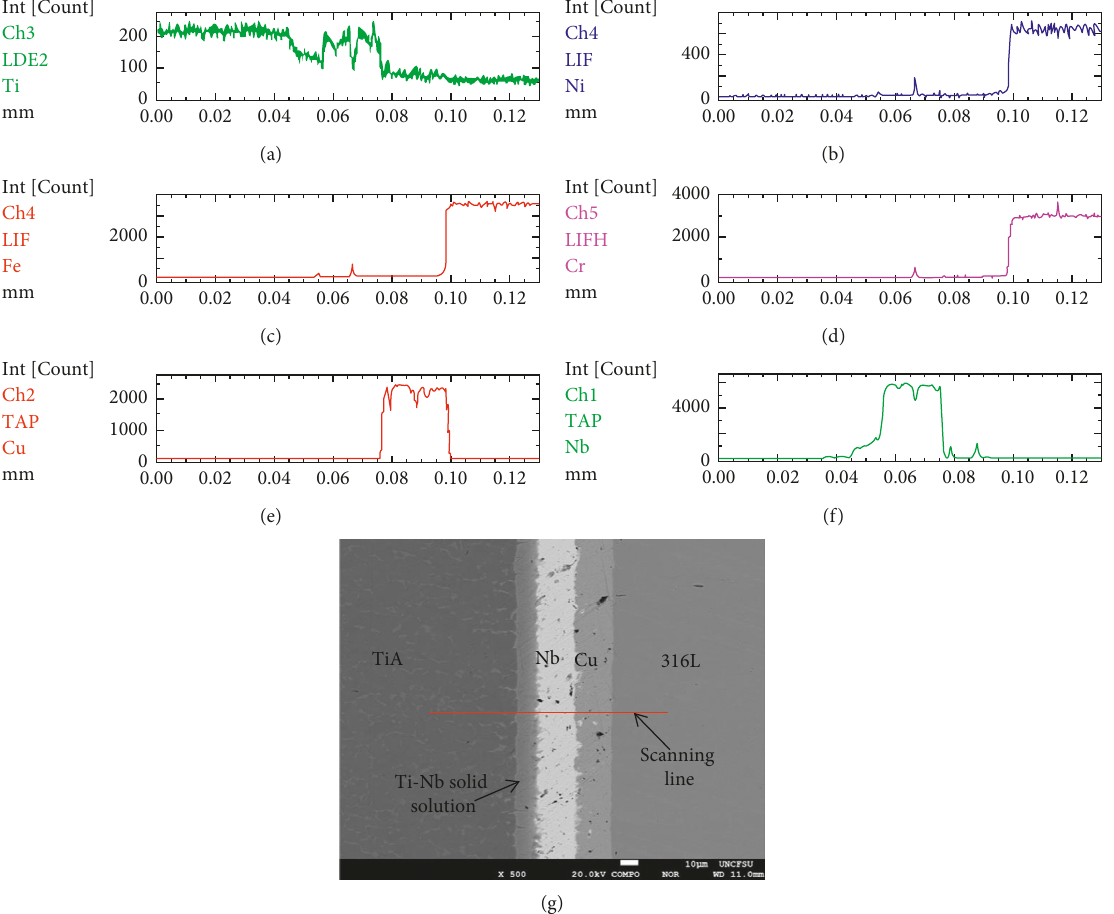
Figure 7: BSE image and corresponding line scanning of the joint bonded at 850 ° C for 20 min (reproduced from [83] with permission). Int [Count]